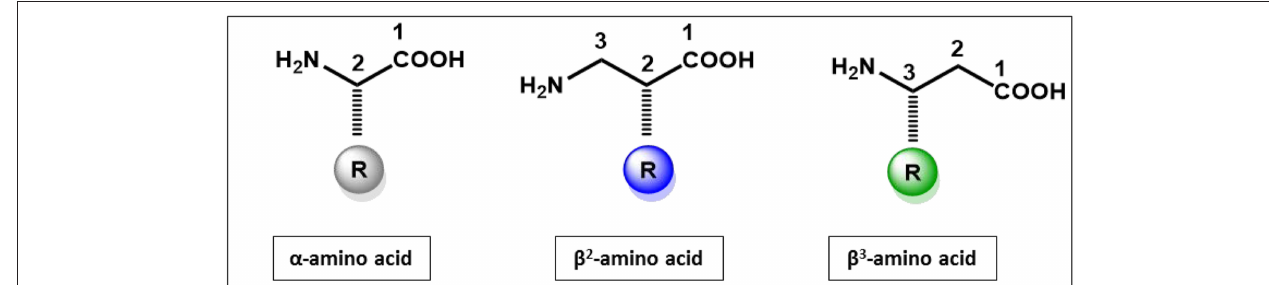
FIGURE 1 | Structural features of α -amino acid, β 2 and β 3 -amino acids.